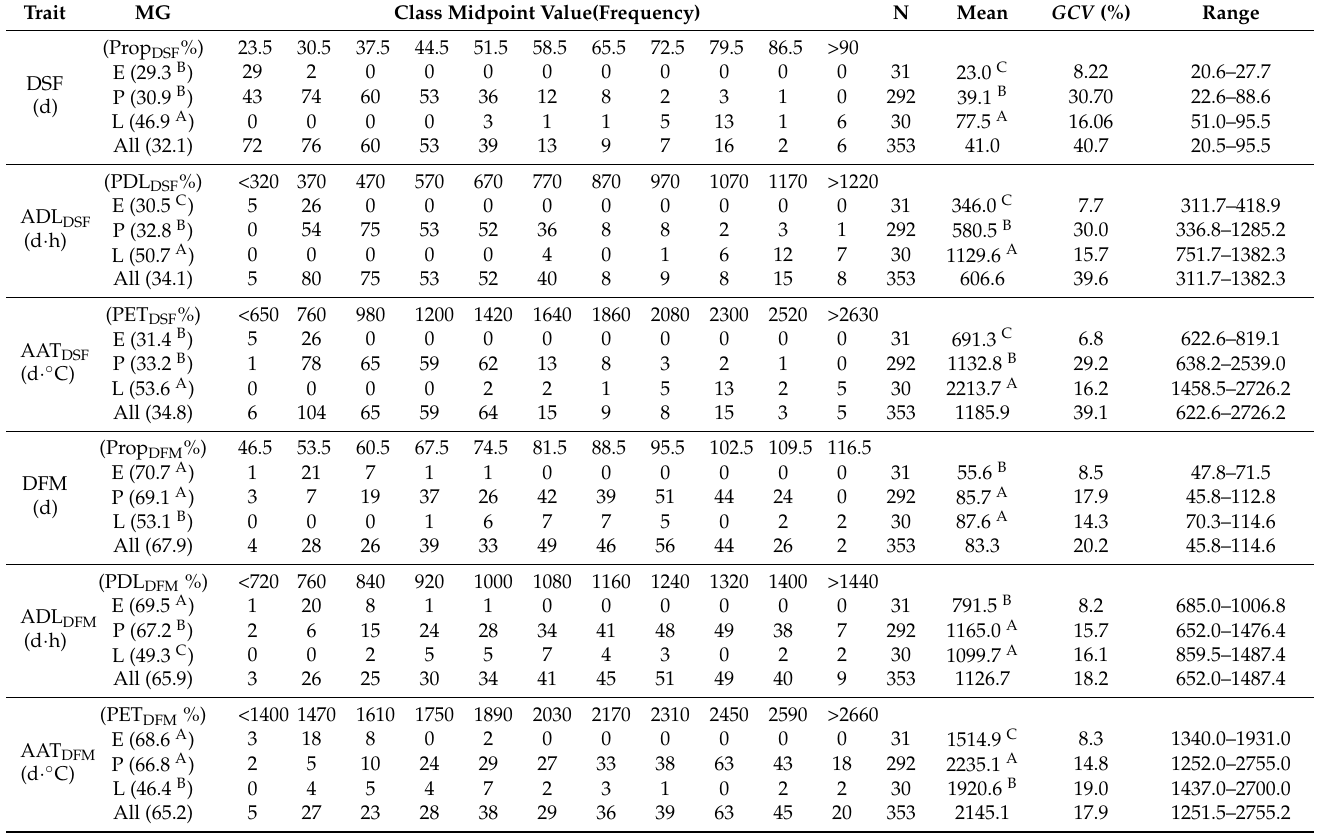
Table 2. Variation of growth period traits, accumulative day length and accumulative active tempera- ture among MG sets in the world soybean germplasm population